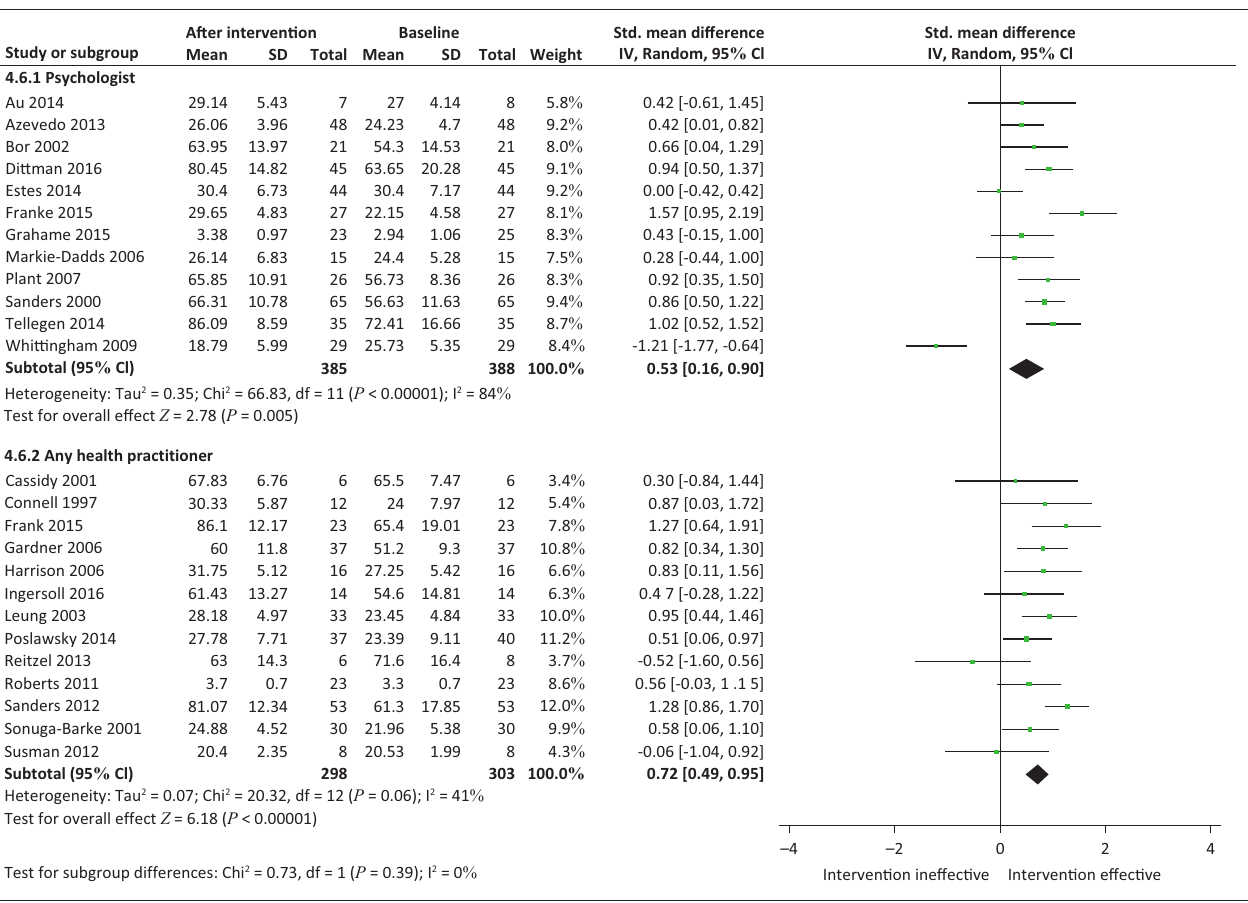
FIGURE 6: Random effects meta-analysis of the summative effects of parent training programmes according to professional delivering the